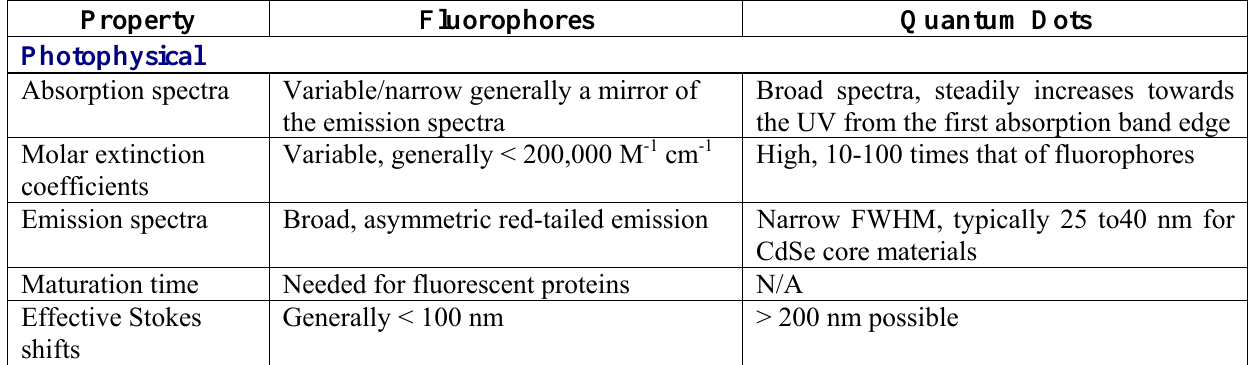
Table 1. Comparison of organic/protein fluorophore and quantum dot properties. Adapted from